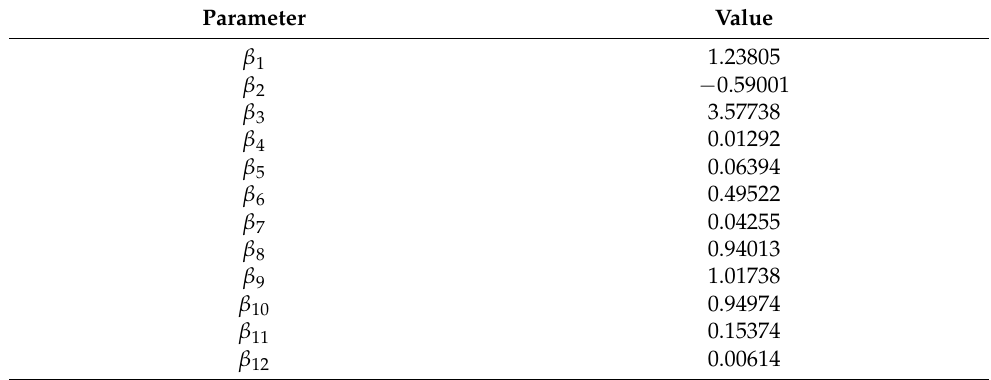
Table 4. Equation (25)